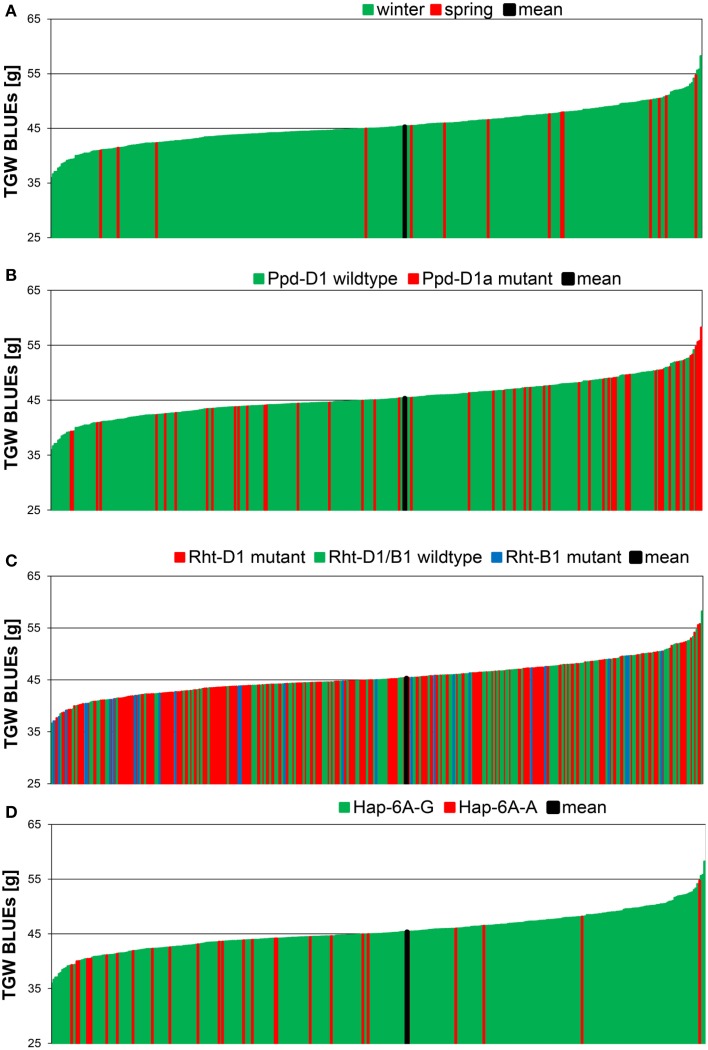
Phenotypic distribution of TGW BLUEs in 372 wheat varieties. The BLUEs of the TGW score were calculated across eight environments. TGW BLUEs were arranged according to the growth habit (A), to the distribution of the Ppd-D1 wildtype or Ppd-D1a mutant gene (B), the distribution of the mutant alleles of the dwarfing genes Rht-B1 and Rht-D1 (C) or the distribution of the haplotypes Hap-6A-G and Hap-6A-A of the TGW candidate gene TaGW2-6A (D).